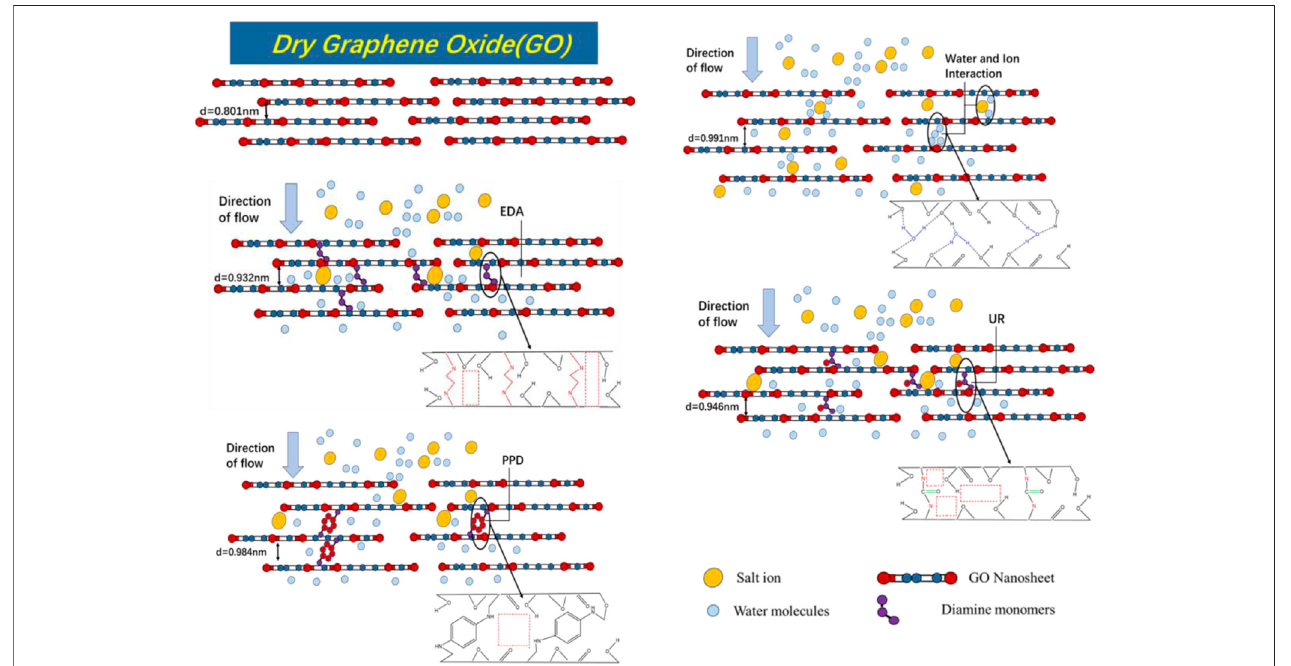
FIGURE 10 | Schematic diagram of GO and composite membrane desalination mechanism and internal physical and chemical structure.